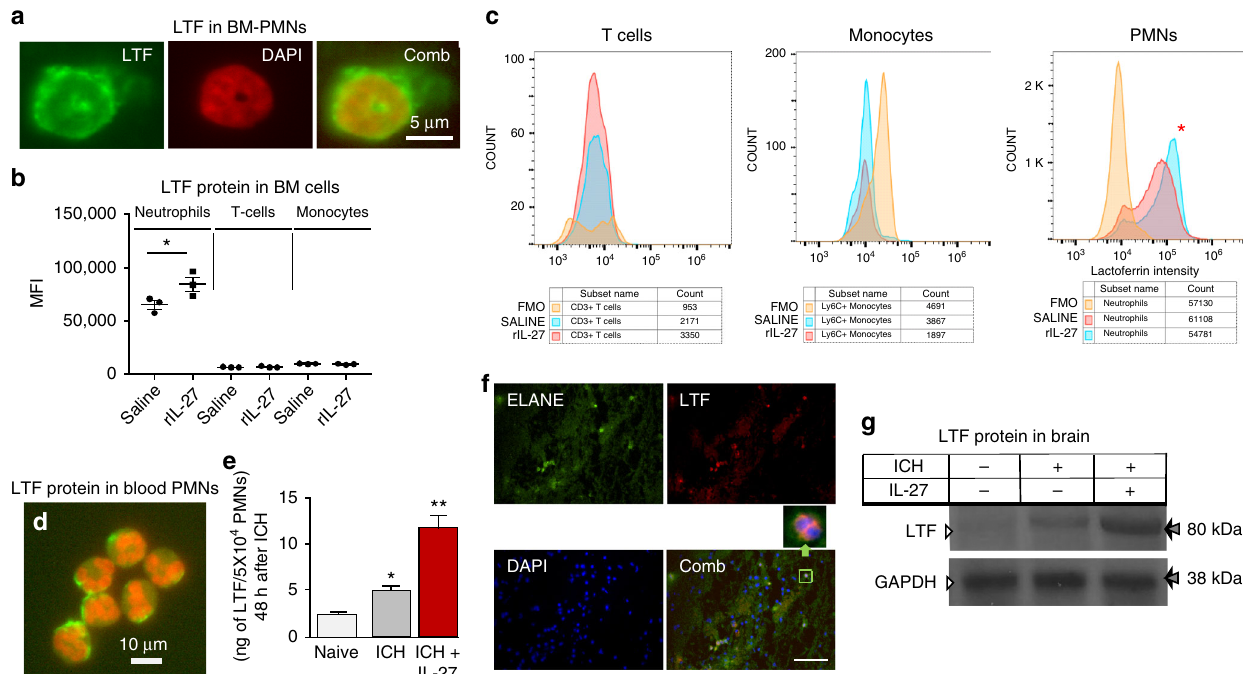
Fig. 5 IL-27 induces LTF in PMNs. a Photomicrograph of representative LTF, immunostaining ( green ) in normal mouse BM-PMNs. The nuclei are stained with DAPI ( red ). b , c MFI of LTF, staining per cell was determined in BM-PMNs by fl ow cytometry, with T cells and monocytes serving as negative controls. Analyzed cells were from mice treated with saline or rIL-27 (50 ng/kg, i.v., at 30 min, 24 h, 42 h after ICH) and harvested at 48 h after the ICH. d Photomicrograph of representative LTF staining ( green ) in peripheral blood mature PMNs. The nuclei were stained with DAPI. Scale bar = 10 μ M. e Bar graph of LTF, protein content (established with ELISA) in peripheral blood PMNs in naïve rats, and rats 48 h after ICH with and without treatment with rIL- 27 (50 ng/kg, i.v., at 30 min, 24 h, 42 h after ICH). Data are expressed as mean ± SEM ( n = 5). * p ≤ 0.05, vs. naïve rat, ** p ≤ 0.05, vs. naïve rats and rats after ICH without IL-27 treatment. The p -value was established using one-way ANOVA followed by Newman – Keuls post-test. f Immuno fl uorescence of LTF, ( red ) and neutrophil elastase, ELANE ( green ) in a mouse brain at hematoma-affected area at 24 h after ICH. The nuclei were labeled with DAPI ( blue ). Scale bar = 50 μ m. The insertion window highlighted the co-localization of LTF, with ELANE + neutrophil. g LTF, protein in the ICH-affected rat brains (harvested from animals perfused with saline to fl ash intravascular cells), in the same animals as in e , and established using Western blot ( n =